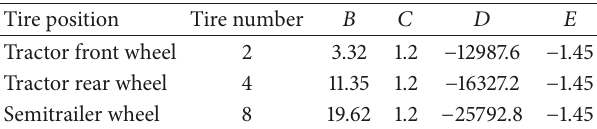
Table 2: Values of 𝐵 , 𝐶 , 𝐷 , and 𝐸 for a nonlinear